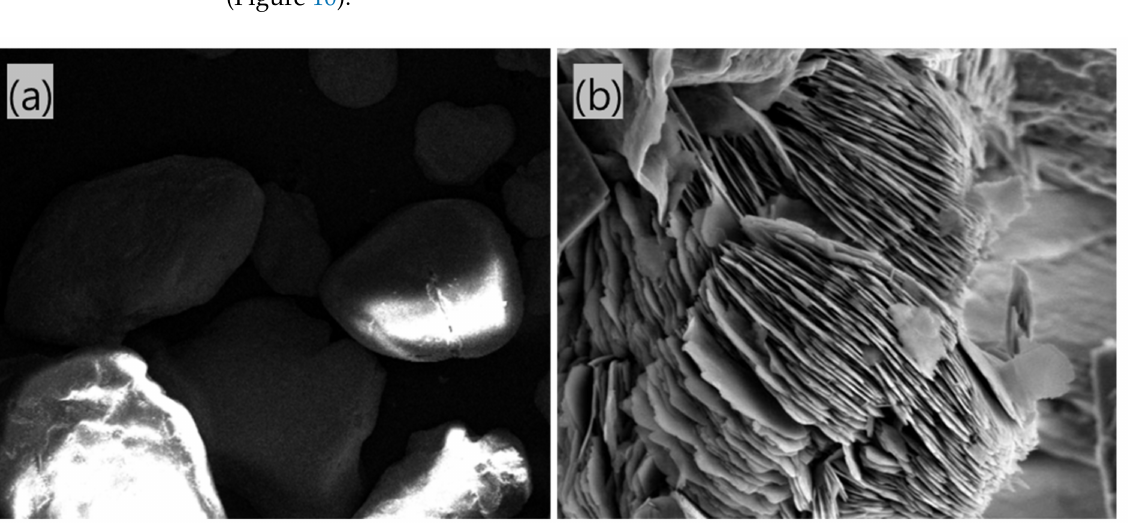
Figure 10. Particle shape: ( a ) CEN standard sand, ( b ) Kaolinite